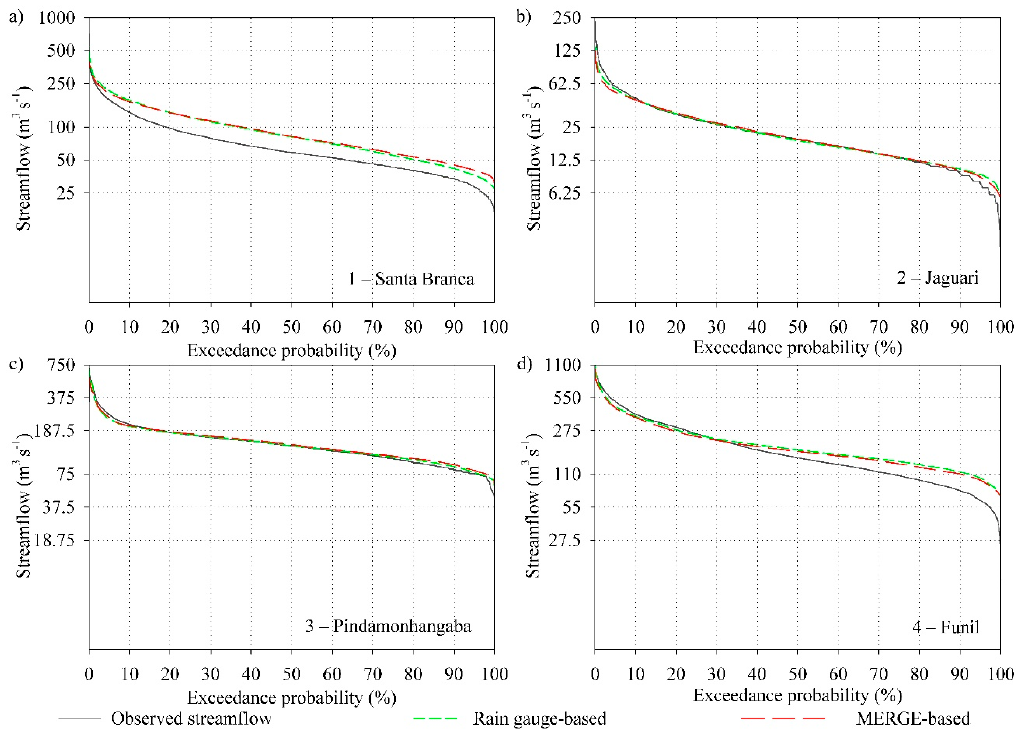
Figure 9. Cumulative frequency curves for the observed and simulated streamflows for watersheds ( a ) 1, ( b ) 2, ( c ) 3, and ( d ) 4.